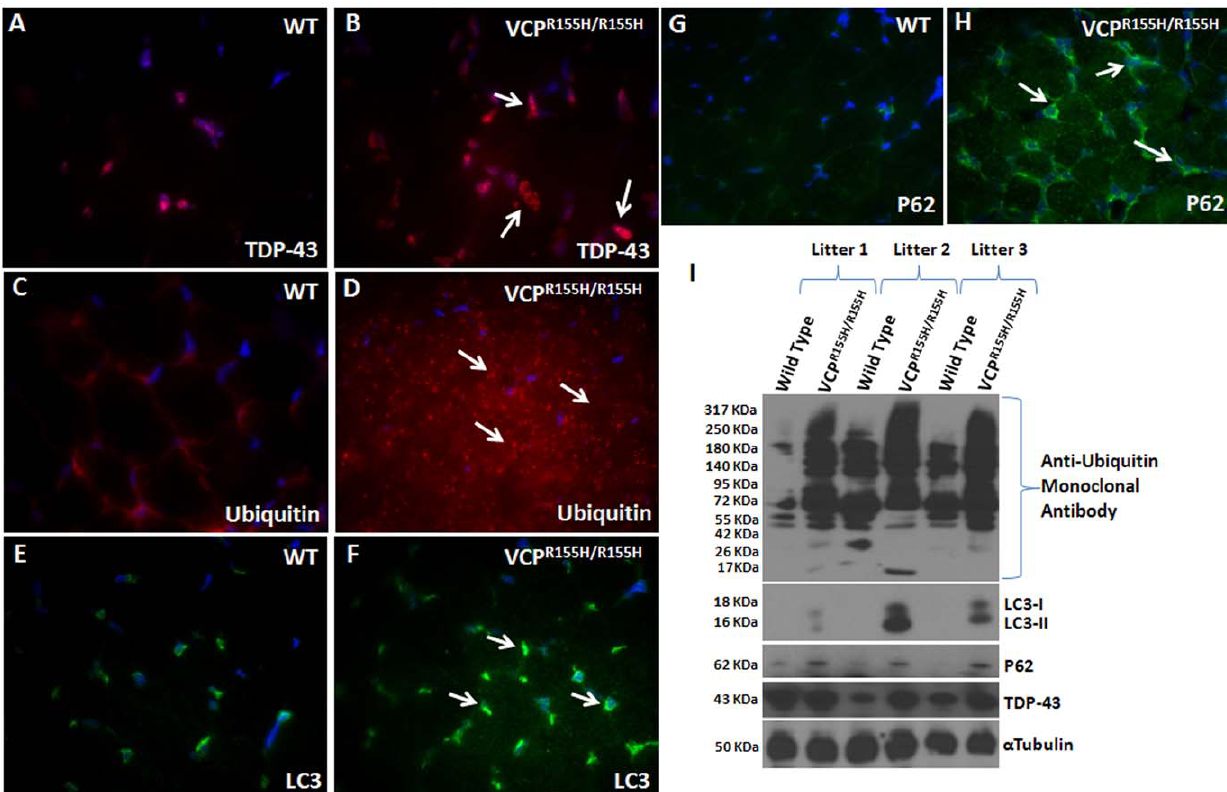
Figure 2. Immunohistochemical analysis of TDP-43 inclusions, ubiquitin, LC3-I/II, and P62 expression levels in VCP R155H/R155H and WT quadriceps. Quadriceps sections revealed increased expression of (A–B) TDP-43, (C–D) ubiquitin, (E–F) LC3-I/II and (G–H) P62 antibodies in VCP R155H/R155H mice as compared to their WT littermates (Mag 63 6 ). (I) Western blot analyses confirmed the increased TDP-43, ubiquitin, LC3-I/II and P62 protein expression levels in the VCP R155H/R155H mice. Alpha tubulin was used as a loading control.